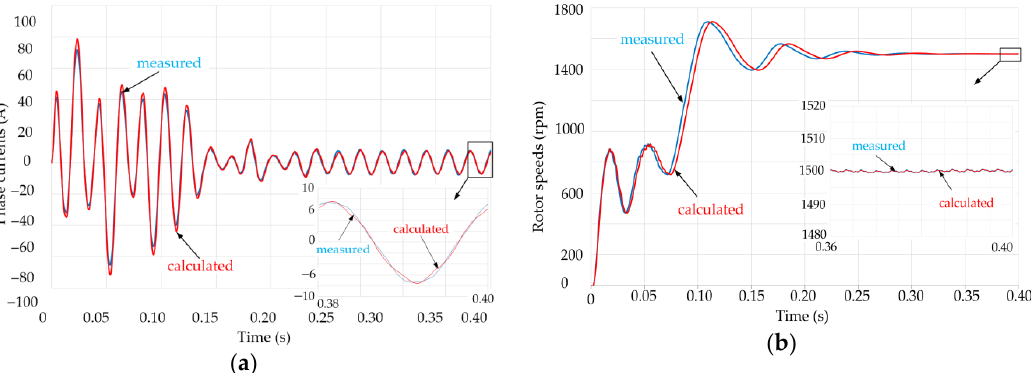
Figure 9. Time curves of ( a ) phase currents and ( b ) rotor speed in τ i = 26°C for T L = 19.5 Nm, J i = 0.0082 kgm 2 .